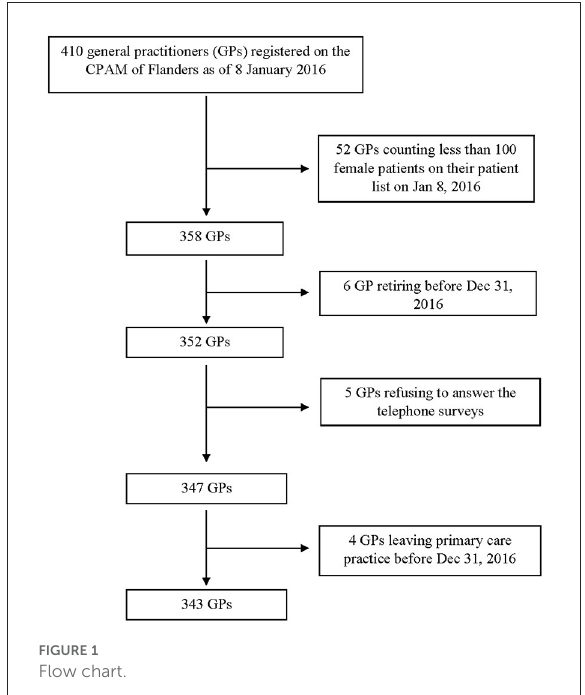
FIGURE1 Flow chart.